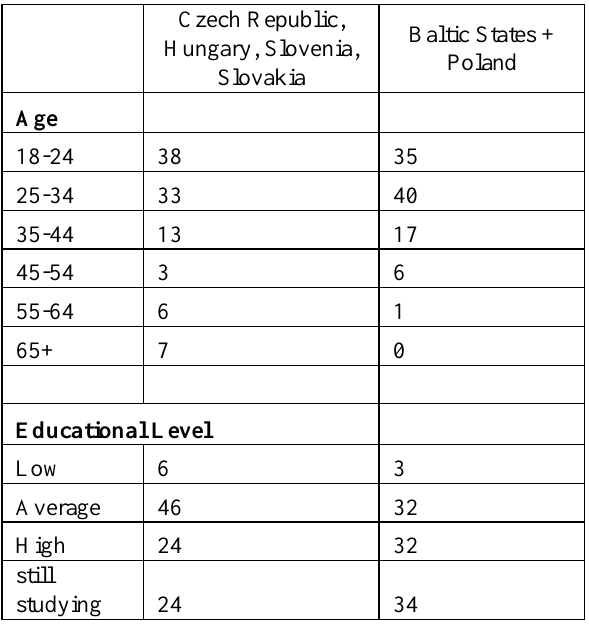
Table 10. Percentage of people who expect to move to another EU country within 5 years by age and educational level